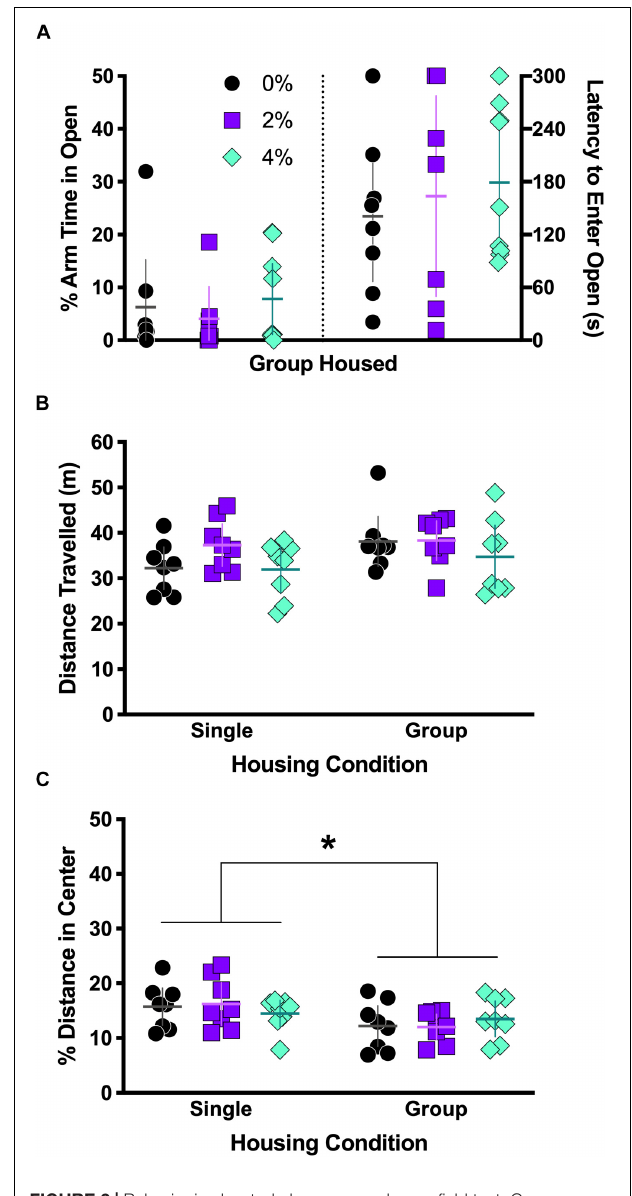
FIGURE 2 | Behavior in elevated plus maze and open field test. Group housed mice from Experiment 2 were tested in the elevated plus maze ( A ). No differences were observed the percent of arm time spent in the open arm ( A , left half) or latency to first entry in the open arm ( A , right half). Single and group housed mice in Experiments 1 and 3, respectively, were tested in the open field ( B , C ). Neither salt nor housing condition significantly affected overall locomotor activity, measured as distance traveled ( B ), though a non-significant trend for a main effect of housing was noted ( p = 0.085). There was a significant main effect of housing on the percent of total distance traveled in the center ( C , ∗ p = 0.013). Individual data points are shown, with means indicated by horizontal lines, and 95% CI indicated with vertical